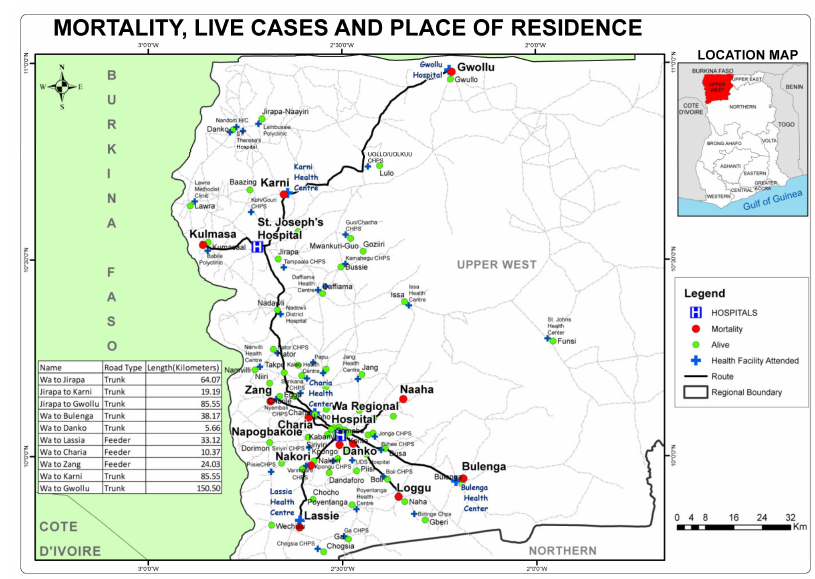
Figure 1. Mortality, live cases, place of residence and health facilities visited by outborn neonates.